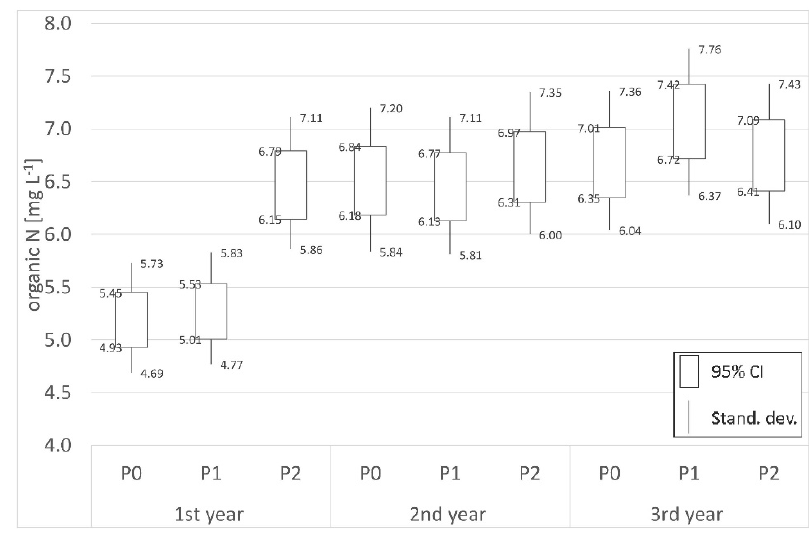
Figure 12. The concentrations of organic N in groundwater under peatland soils.